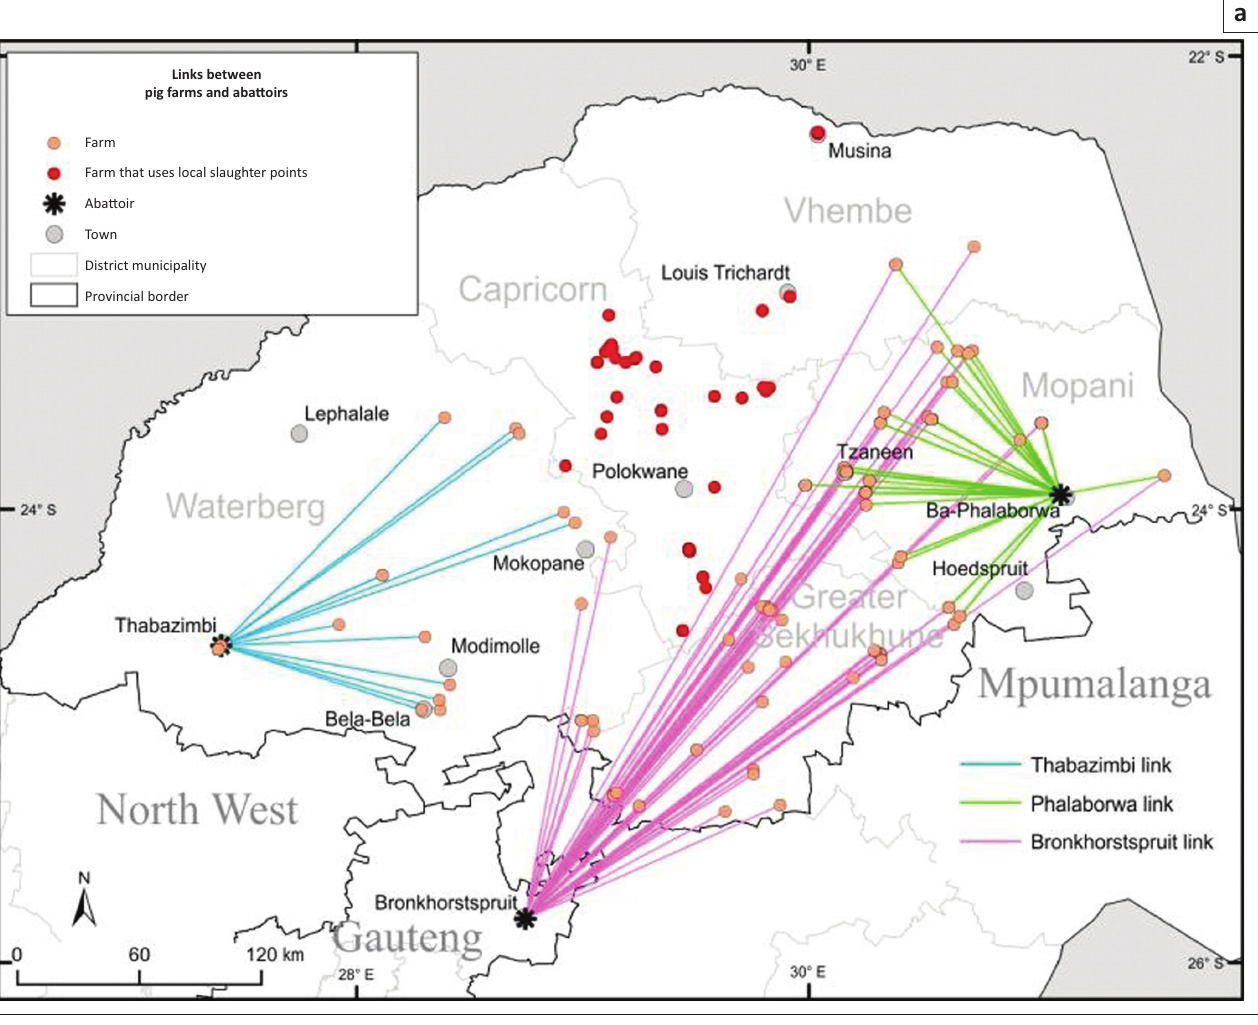
FIGURE 2: (a) Unidirectional links between ESSPF and destinations of final products. (b) Unidirectional links between ESSPF and preferred auction